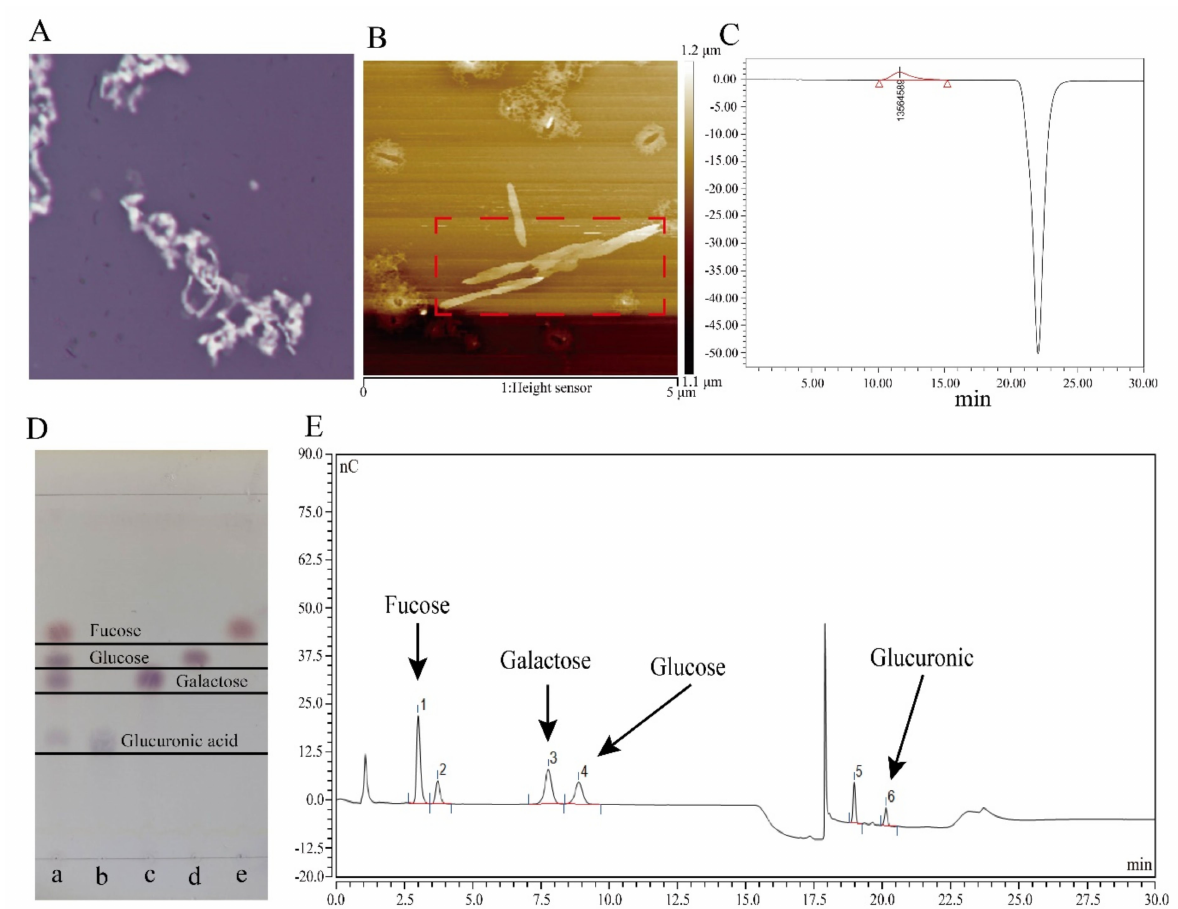
Figure 2. Characterization of colanic acid. ( A ) Image of Escherichia coli K-12 cells with colanic acid capsule observed by microscope. ( B ) Atomic force microscopy results of the colanic acid polysac- charide. In the red box was colanic acid polysaccharide. ( C ) Evaluation of the molecular weight of colanic acid by high-performance gel liquid chromatography. ( D ) Thin layer chromatography re-sults of the colanic acid hydrolyzate. Lane a was the hydrolyzed sample. Lanes b, c, d, and e were glucuronic acid, galactose, glucose, and fucose standards, respectively. ( E ) Ionic liquid chroma- tography results of the colanic acid hydrolysate. Peaks 1, 3, 4 and 6 were fucose, galactose, glucose and glucuronic acid,